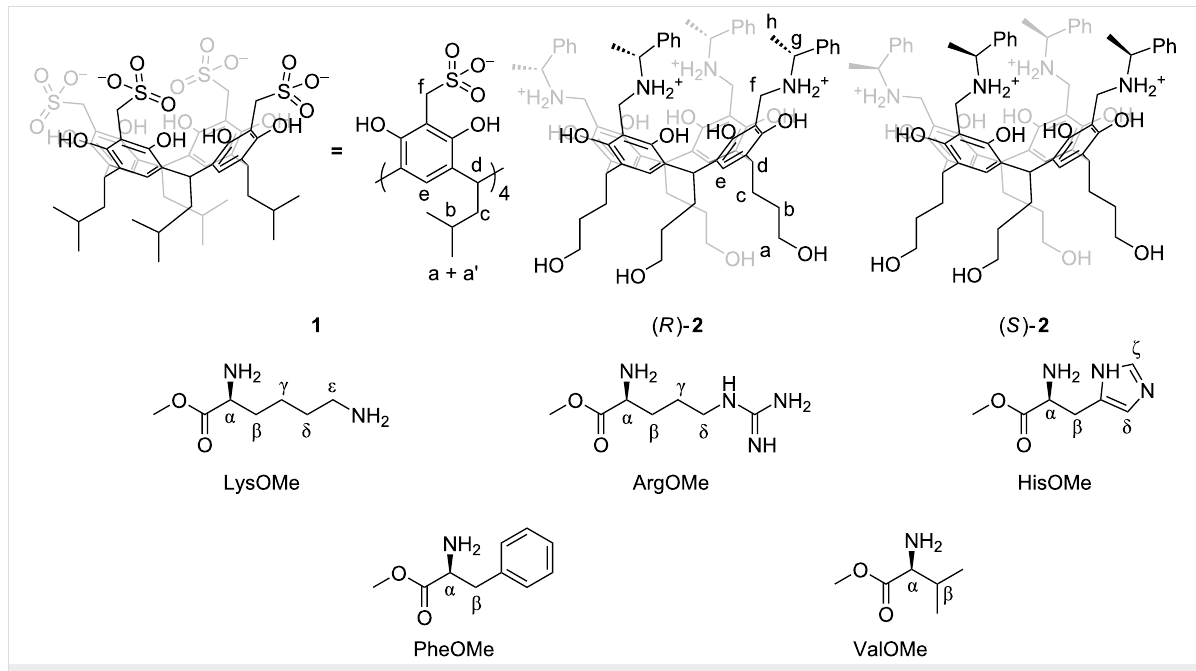
Figure 1: Structures of the compounds used in this study and labelling scheme for NMR